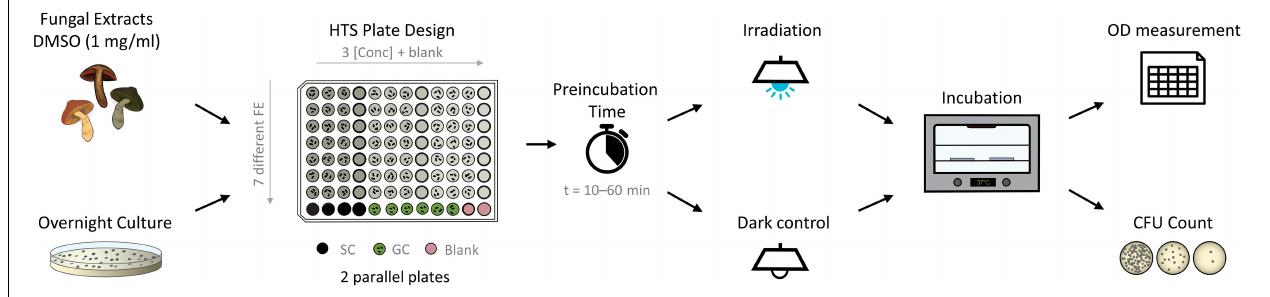
FIGURE 2 | Flow chart of photo-antimicrobial (high-throughput screening; HTS) based on the microdilution method. The pipetting scheme represents the fast screening approach of extracts. Up to seven different fungal extracts with three concentrations each are tested on one plate. SC, sterility control; GC, growth control.